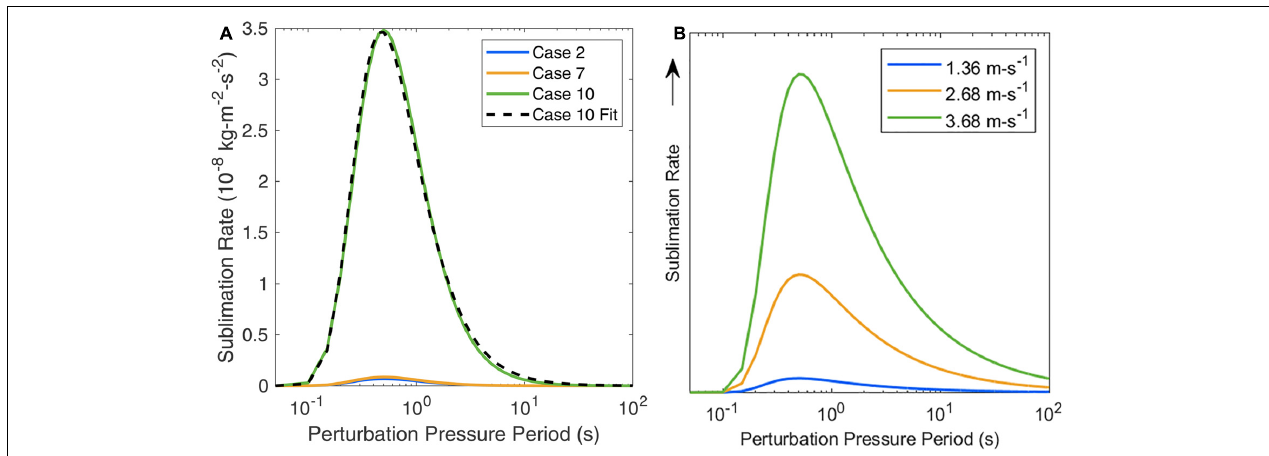
FIGURE 7 | Simplified M-O model results in panel (A) show sublimation rates as a function of oscillation period for cases 2, 7 and 10. The integral of the curve is the sublimation rate for each case. Initializing the Gaussian model (panel B ) with the average wind speeds for cases in panel (A) , we find a similar functional relationship between the simplified M-O and the Gaussian model. The Gaussian model overpredicts the sublimation contribution of longer period pressure fluctuations and also overpredicts sublimation at low wind speed for these